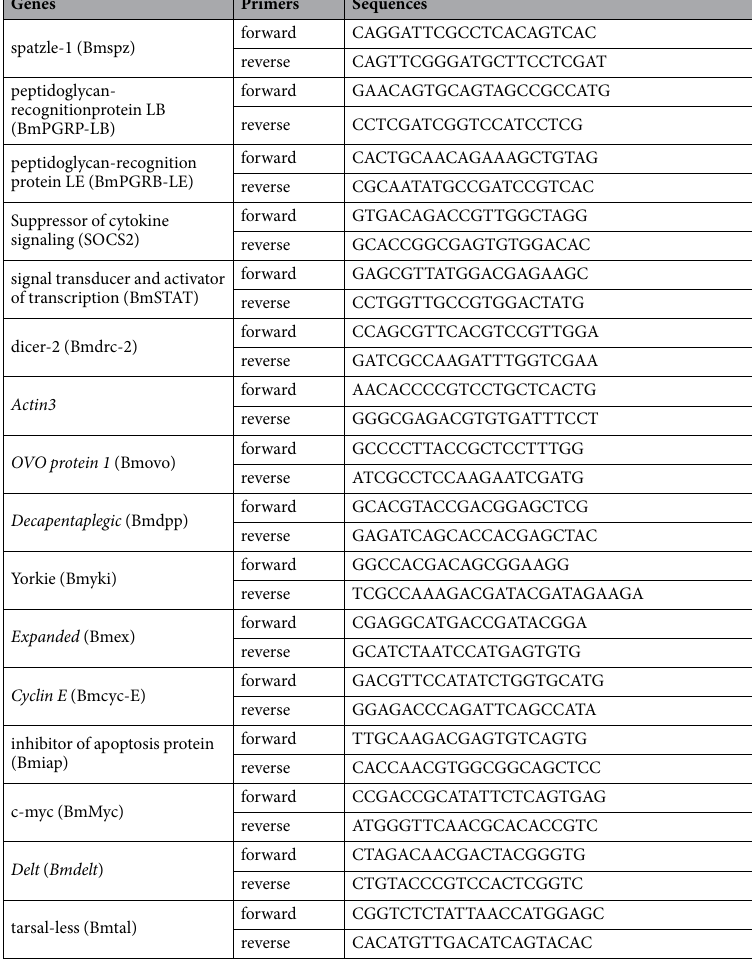
Table 1. The primers used in this